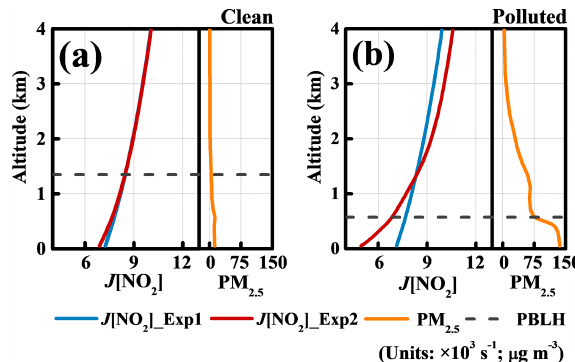
Figure 3. Mean profiles of J (NO 2 ) (red and blue lines) and PM 2 . 5 (orange line) at 12:00LT on clean days (a) and polluted days (b) . Profiles of J (NO 2 ) in Exp1 and Exp2 are denoted by red and blue, respectively. Mean PBL heights (PBLH; dashed black line) of the two kinds of days are also presented in (a) and (b) ,